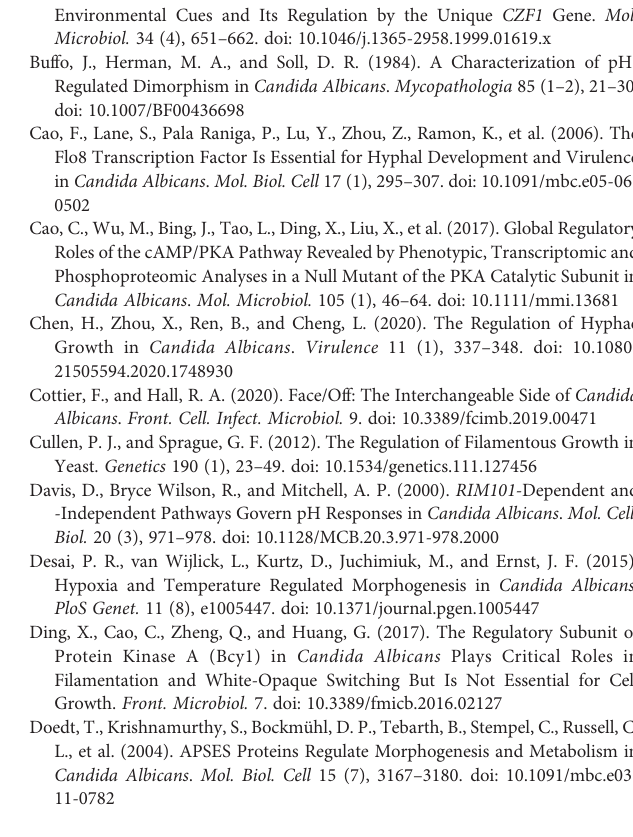
between the efg1 D / D deletion mutant and wild type using gene expression microarray of cells in mid-log phase in synthetic complete media, Efg1 binding